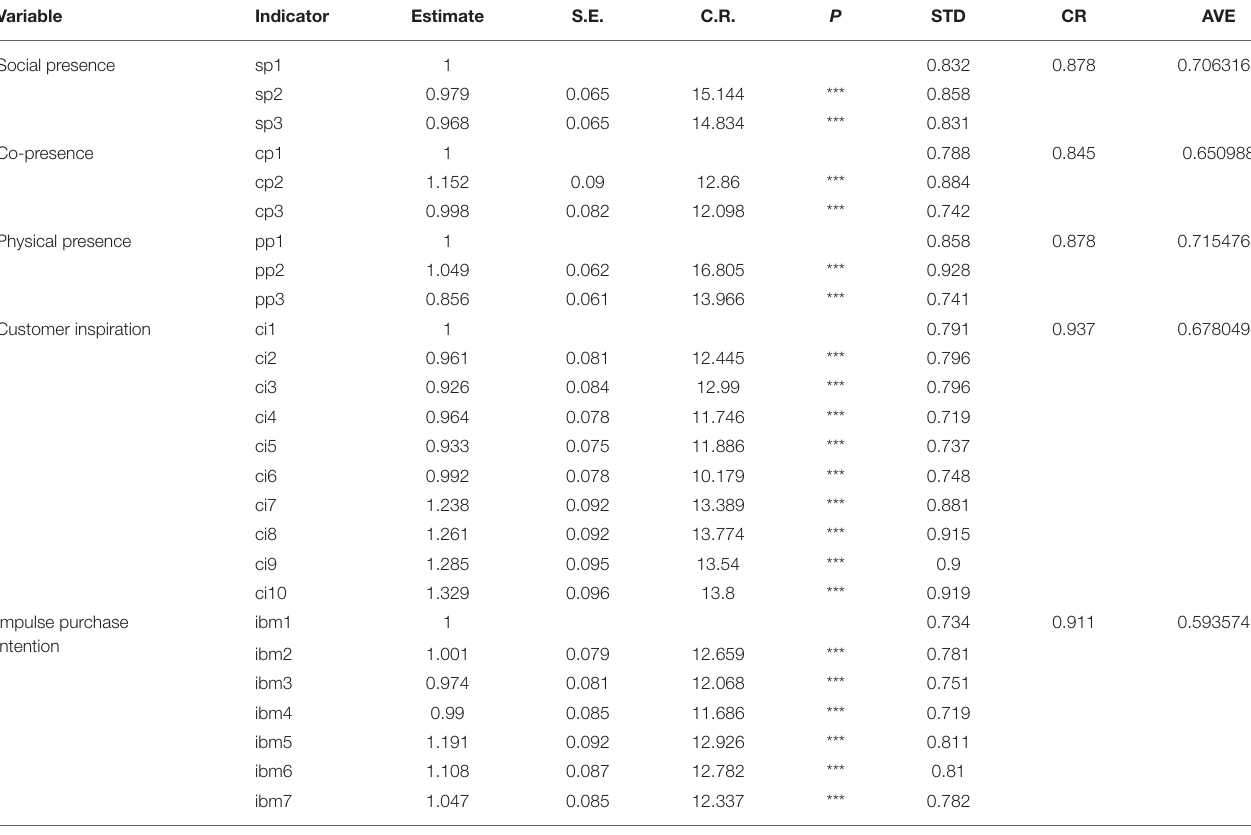
TABLE 5 | Convergence validity test of measurement model.